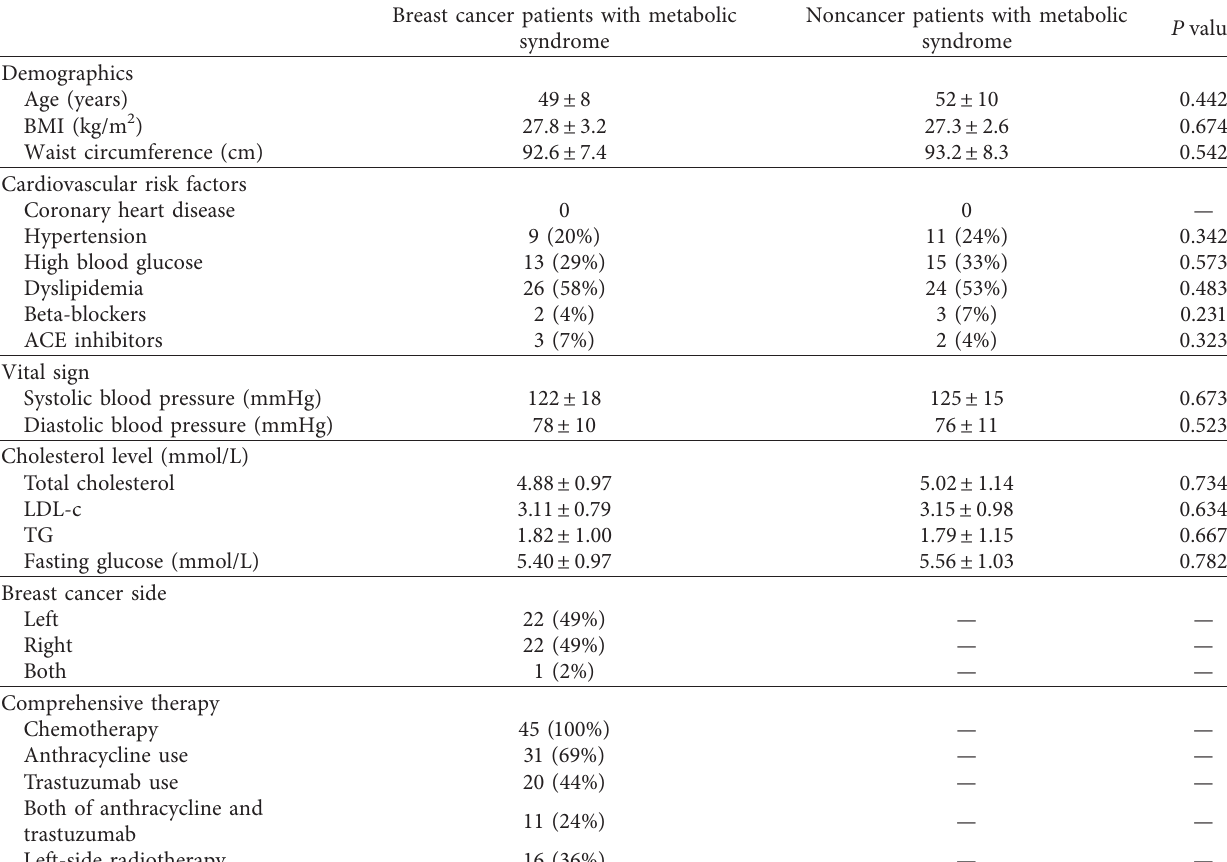
Table 1: Baseline characteristics of breast cancer and noncancer patients with metabolic